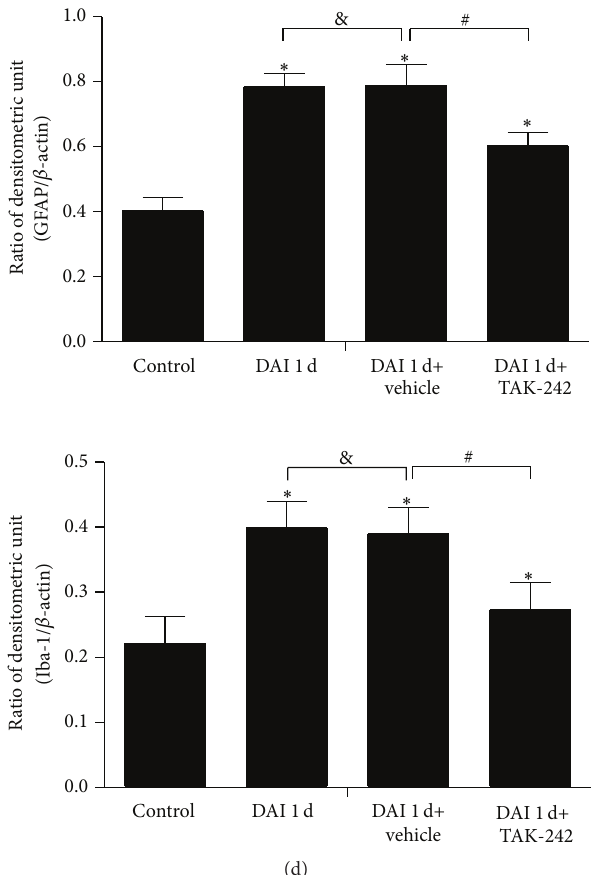
Figure 8: TLR4 inhibition attenuated glial responses. (a) The immunoreactivity of the astrocyte marker GFAP and that of the microglial cell marker Iba-1 were assessed via immunohistochemistry in rat cortices in the control, DAI 1d, DAI 1d+vehicle, and DAI 1d+TAK-242 groups. Scalebar=50 𝜇 m.(b)ThebargraphsshowtheresultsforGFAPandIba-1immunoreactivity,asdeterminedviaimmunohistochemistry.GFAP and Iba-1 levels were assessed in 5 random fields (40x magnification) by immunohistochemical scores (IHS). (c) GFAP and Iba-1 expression was measured via western blotting. (d) The bar graphs show the results for GFAP and Iba-1 expression, as determined via western blotting. Data are presented as the mean ± SD ( 𝑛 = 6 ; ∗ 𝑝 < 0.05 , compared with control group; # 𝑝 < 0.05 , & 𝑝 > 0.05 , compared with DAI 1 d+vehicle